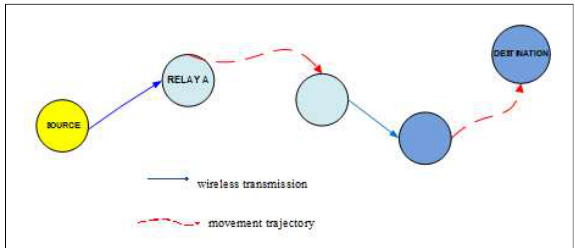
Figure 4. Two-hop communication in a mobile ad hoc network